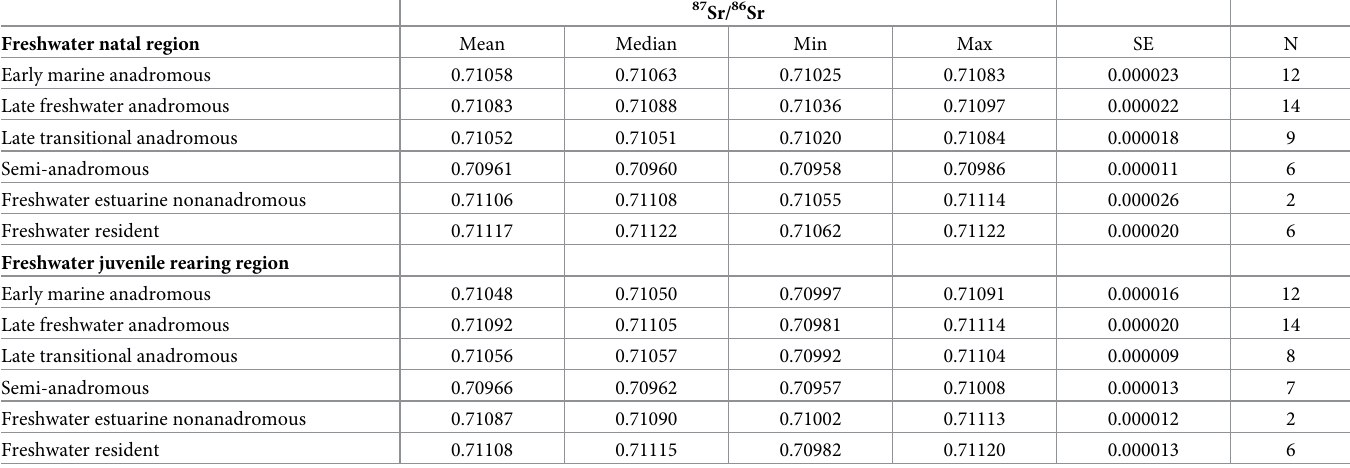
Table 3. Summary of GAM predicted 87 Sr/ 86 Sr for freshwater natal and freshwater juvenile rearing regions across life history types of Broad Whitefish ( Coregonus nasus ) captured in the Colville River, AK,